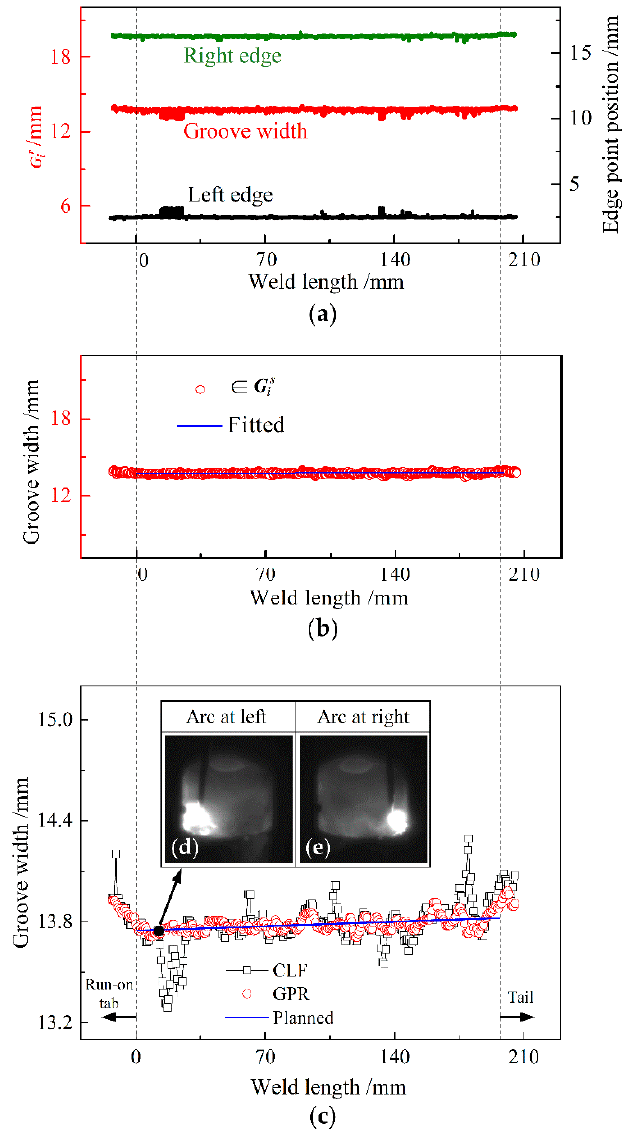
Figure 9. Detected results of constant-width groove: ( a ) edge point positions and instantaneous groove widths containing 322 sets of G i r ; ( b ) true data belonging to G i s and fitting line of the true data; ( c ) comparison of detected groove-width values with the planned ones; ( d ) example of global image for arc at left; ( e ) example of global image for arc at right.